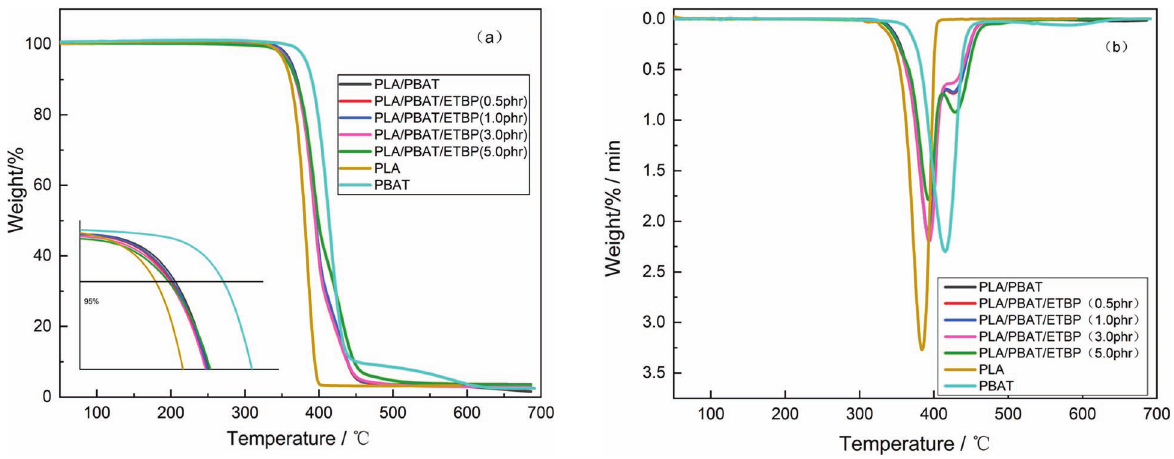
Figure 5: TGA (a) and DTG (b) curves of the PLA/PBAT blends with different content of